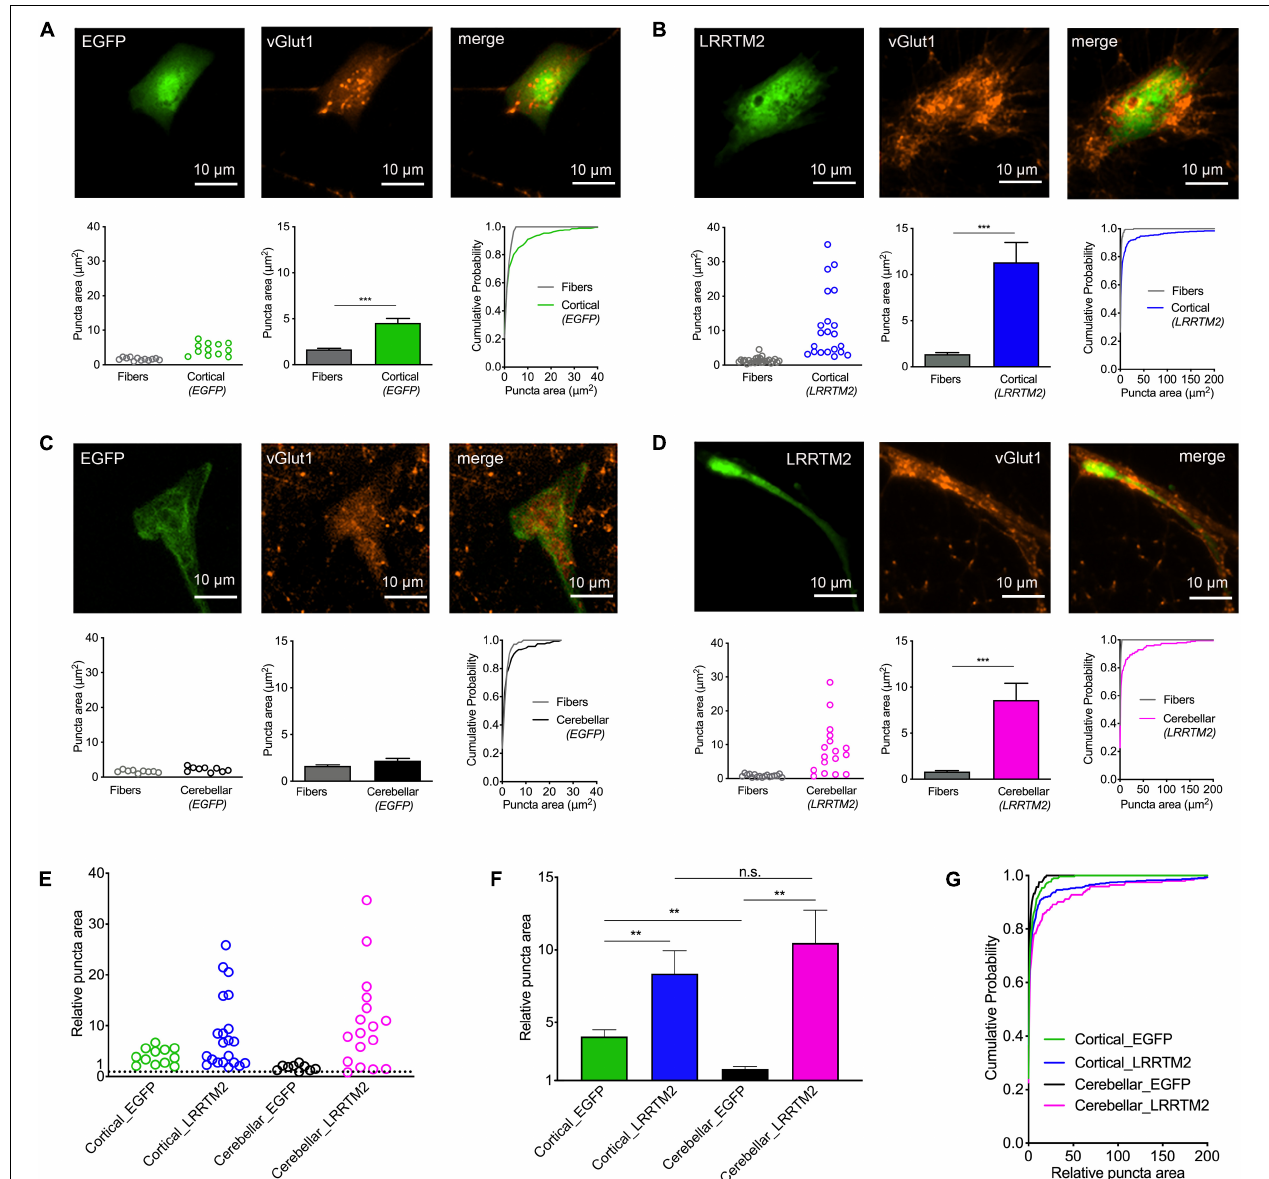
FIGURE 4 | Induction of synaptic vesicle clusters in axons by LRRTM2 expression in immature cortical and cerebellar astrocytes. (A–D) Immunostaining for vGlut1 revealed induction of vesicle clusters in axons by LRRTM2 expression in target cells. (A) Expression of only EGFP (control) in immature cortical astrocytes. Upper panel: EGFP fluorescence (left image), immunocytochemistry for vGlut1 (middle image), and merge image. Lower panel: Quantification of vesicle cluster area on target cells (green) and in non-contacting axons (fibers) [left: means of individual cells ( n = 12/12); middle: means of cells ± SEM; right: cumulative distribution of the areas of all puncta (86/300)]. (B) Expression of LRRTM2 + EGFP (co-transfection) in immature cortical astrocytes. Upper panel: EGFP fluorescence (left image), immunocytochemistry for vGlut1 (middle image), and merge image. Lower panel: Quantification of vesicle cluster area on target cells (blue) and in non-contacting axons (fibers) [left: means of individual cells ( n = 21/21); middle: means of cells ± SEM; right: cumulative distribution of the areas of all puncta (177/462)]. (C) Expression of only EGFP (control) in cerebellar astrocytes. Upper panel: EGFP fluorescence (left image), immunocytochemistry for vGlut1 (middle image), and merge image. Lower panel: Quantification of vesicle cluster area on target cells (black) and in non-contacting axons (fibers) [left: means of individual cells ( n = 9/9); middle: means of cells ± SEM; right: cumulative distribution of the areas of all puncta (72/163)]. (D) Expression of LRRTM2 + EGFP (co-transfection) in cerebellar astrocytes. Upper panel: EGFP fluorescence (left image), immunocytochemistry for vGlut1 (middle image), and merge image. Lower panel: Quantification of vesicle cluster area on target cells (magenta) and in non-contacting axons (fibers) [left: means of individual cells ( n = 17/17); middle: means of cells ± SEM; right: cumulative distribution of the areas of all puncta (113/194)]. (E–G) Quantitative comparison of the effect sizes of EGFP (control) and LRRTM2 + EGFP expression in immature cortical and cerebellar astrocytes (calculated from data in A–D ). vGlut1 puncta areas on target cells were normalized to the respective mean puncta area in non-contacting axons. (E) Means of normalized puncta areas of individual cells. (F) Means of cells ± SEM. (G) Cumulative distributions of the normalized areas of all puncta. *** P < 0.001; Student (cid:48) s t -test (A–D) ; ** P < 0.01; one-way ANOVA with Tuckey’s post-hoc test (F) .